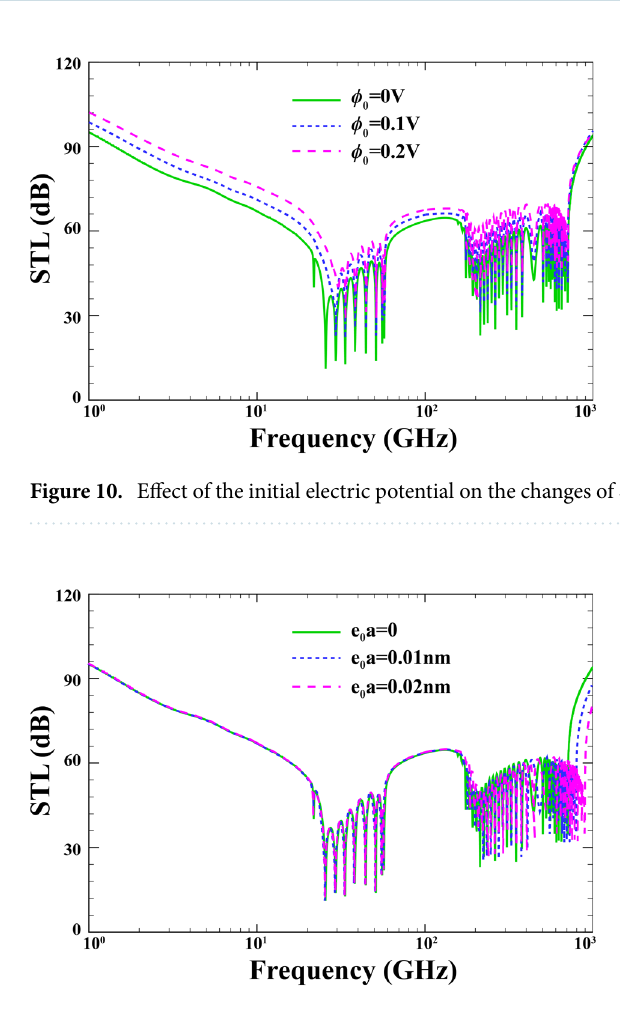
Figure 11. Effect of the nonlocal parameter on the changes of